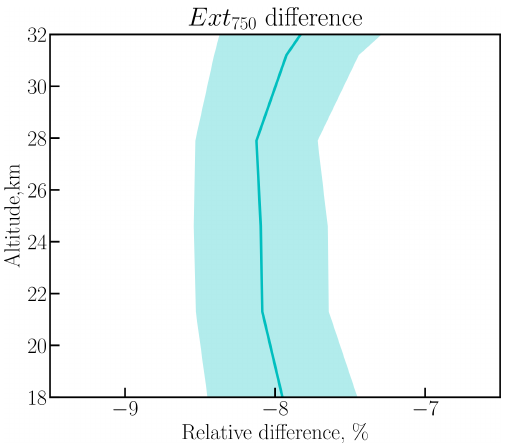
Figure 5. Mean relative difference (200 × (SCIAMACHY- SAGE II)/(SCIAMACHY+SAGE II)) between extinction coef- ficients at 525nm (blue line), 1020nm (green line) and 750nm obtained directly from PSD (red line) and 750nm converted with α 525 / 1020 (magenta line) from collocated SCIAMACHY and SAGE II measurements. Shaded areas show standard error of the mean.